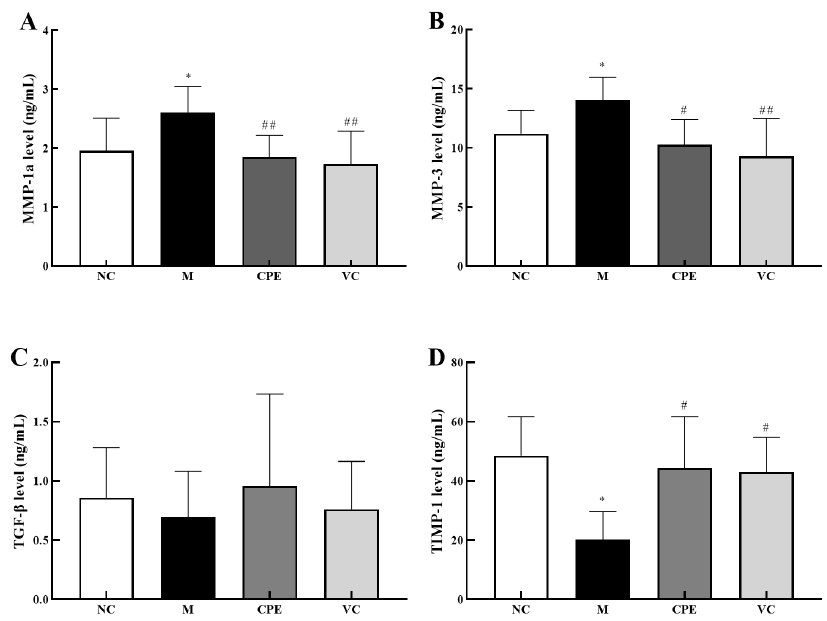
Figure 7. MMP-1a, MMP-3, TIMP-1 and TGF- β levels in mice skin. Note: ( A ): MMP-1a content in mouse skin tissue; ( B ): MMP-3 content in mouse skin tissue; ( C ): TGF- β content in mouse skin